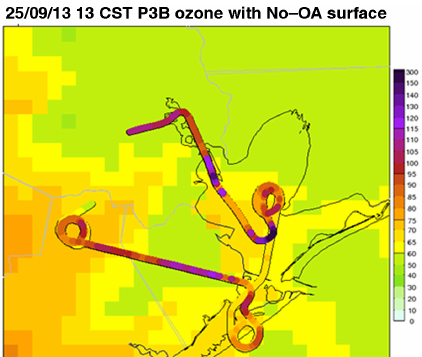
Figure 11. Ozone along aircraft tracks at 08:00CST on 25 Septem- ber, overlaid upon model No-OA surface ozone. The numerical range of the right-side color scale is 0 to 300ppb. Higher values than 300ppb have the same color as 300ppb.